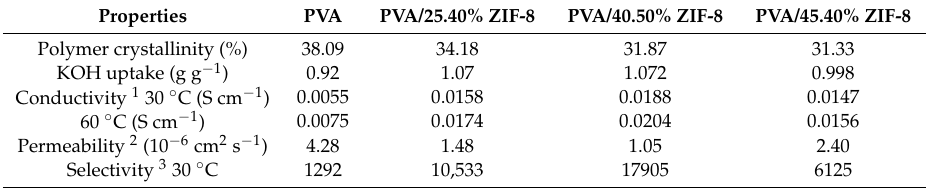
Table 1. Properties of the ZIF-8 nanoparticles and PVA/ZIF-8 composite.